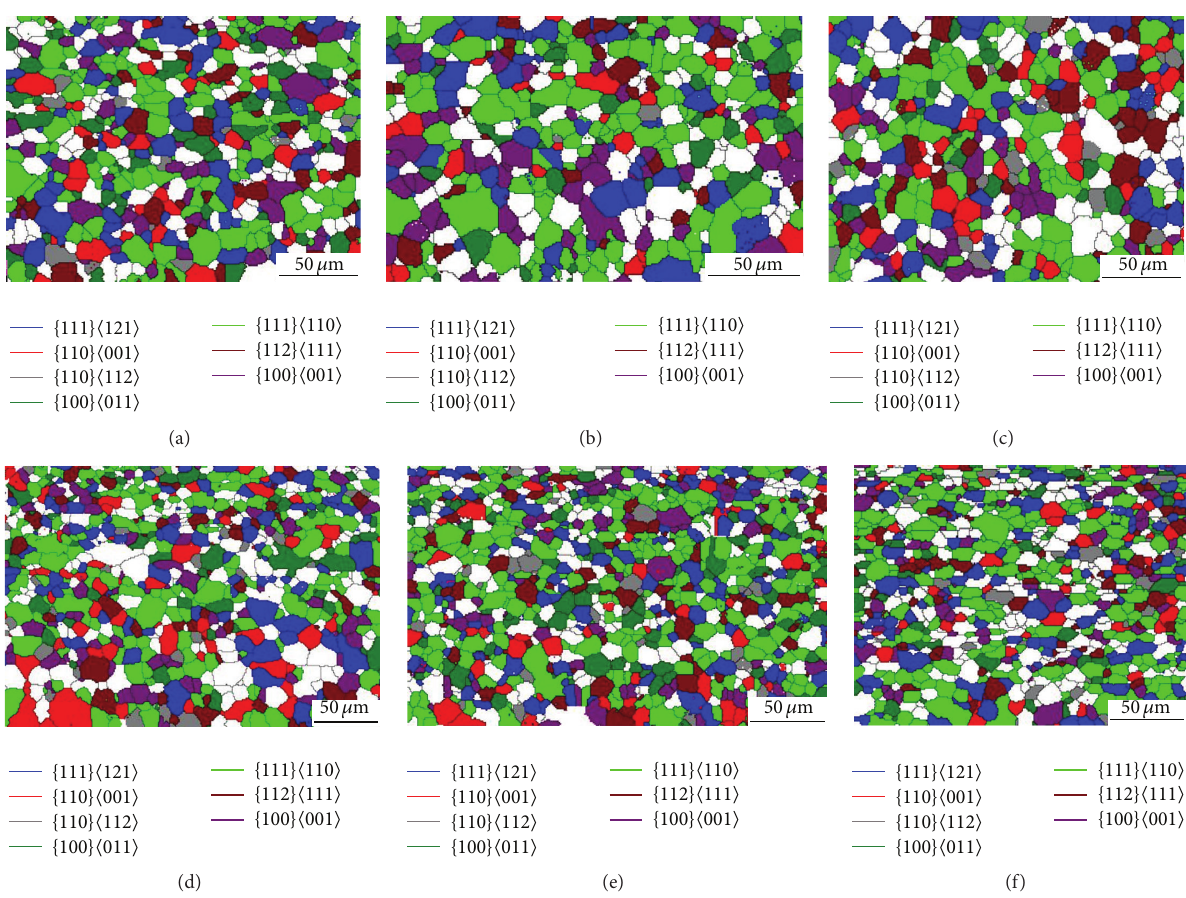
Figure 3: Grain orientation mapping of tested samples under different intermediate temperatures during primary recrystallization: (a) 800 ∘ C + 850 ∘ C; (b) 840 ∘ C + 850 ∘ C; (c) 860 ∘ C + 850 ∘ C; (d) 800 ∘ C + 820 ∘ C; (e) 840 ∘ C + 820 ∘ C; (f) 860 ∘ C + 820 ∘ C.